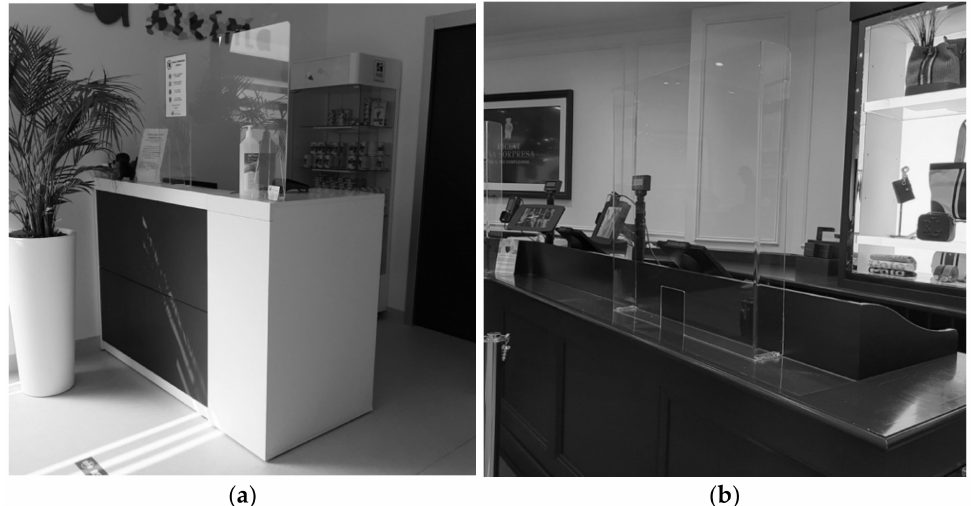
Figure A7. Images illustrating temporary transparent barriers (H) installed on shop desks ( a , b ).